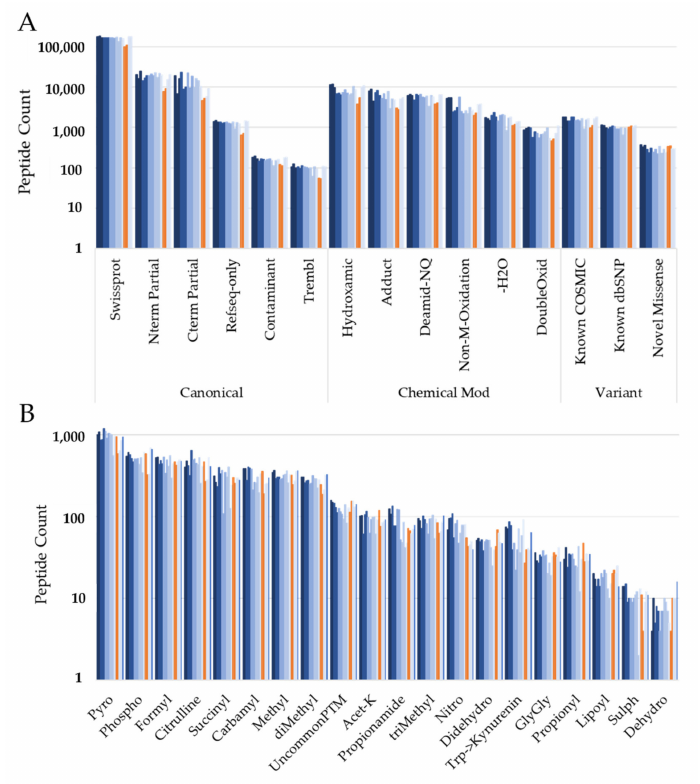
Figure 5. Distribution of various Bolt peptides for each TMT plex. Blue represents tumor TMT plex, and orange bars represent control TMT plexes in different categories: ( A ) canonical, chemical modification, sequence variant; ( B ) different biological modification